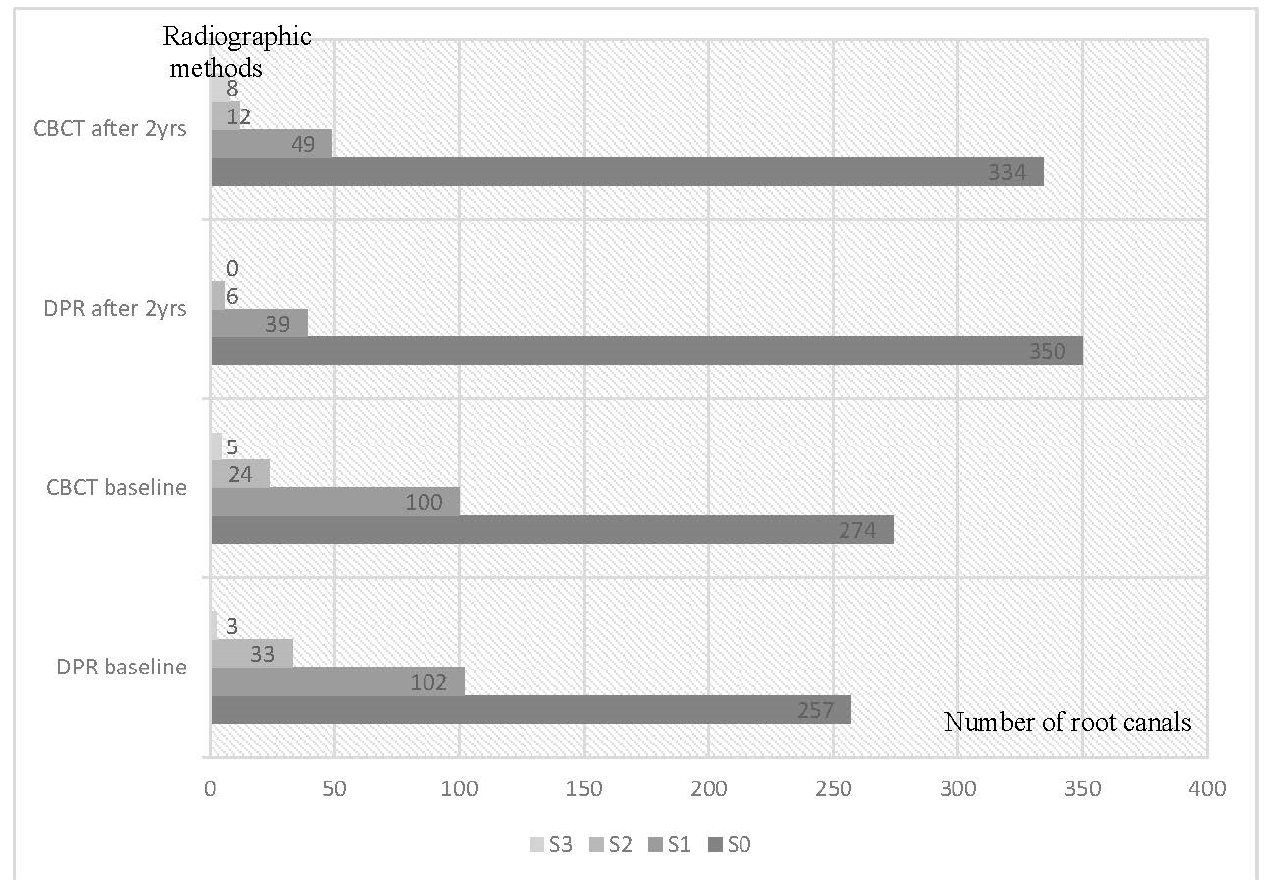
Figure 1. Overall distribution of scores for the size of radiolucency (S) detected by DPR and CBCT at baseline and 2 years of follow-up (n-root canal). Table 2. Site-specific comparison of the non-matching scores of periapical radiolucencies detected by DPR and CBCT, concerning the severity of periapical radiolucency, at baseline and after two years.